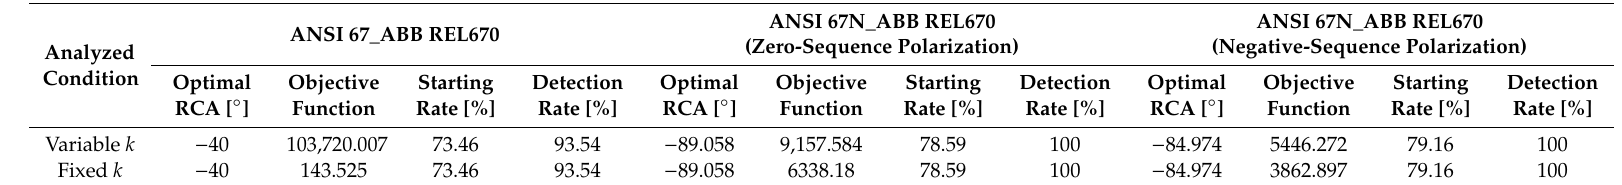
Table 2. Obtained results for the REL670 relay at LT_1 SE_A and optimal RCA.